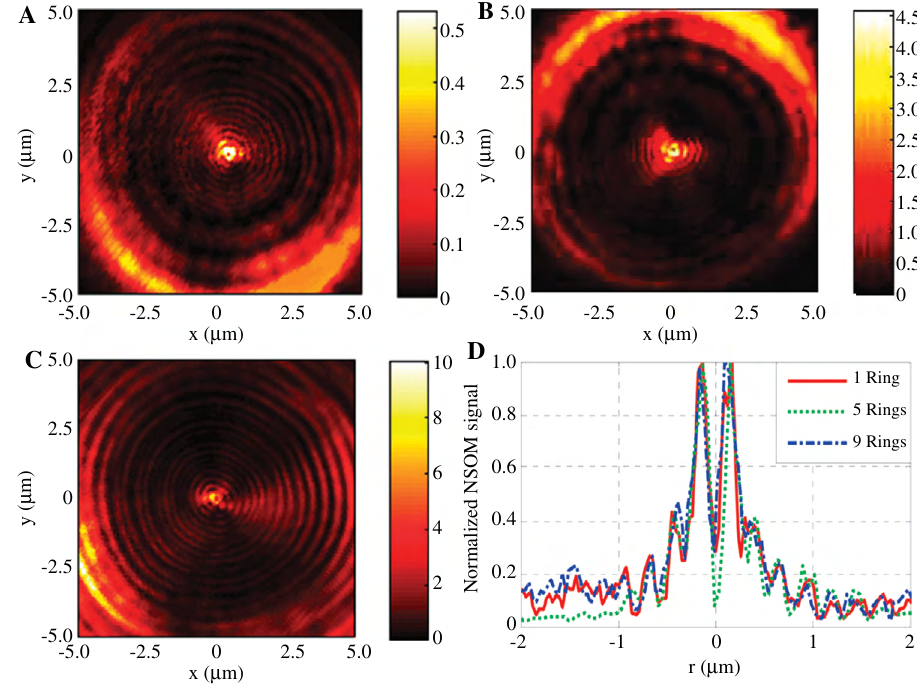
Figure 16 Measured near-field energy density distribution at the silver/air interface for (A) single ring (B) 5-ring and (C) 9-ring plasmonic antenna. (D) Measured normalized transverse profiles of energy density distribution through the center of bull’s eye plasmonic antenna with single ring, 5-ring and 9-ring. Adapted from Ref.